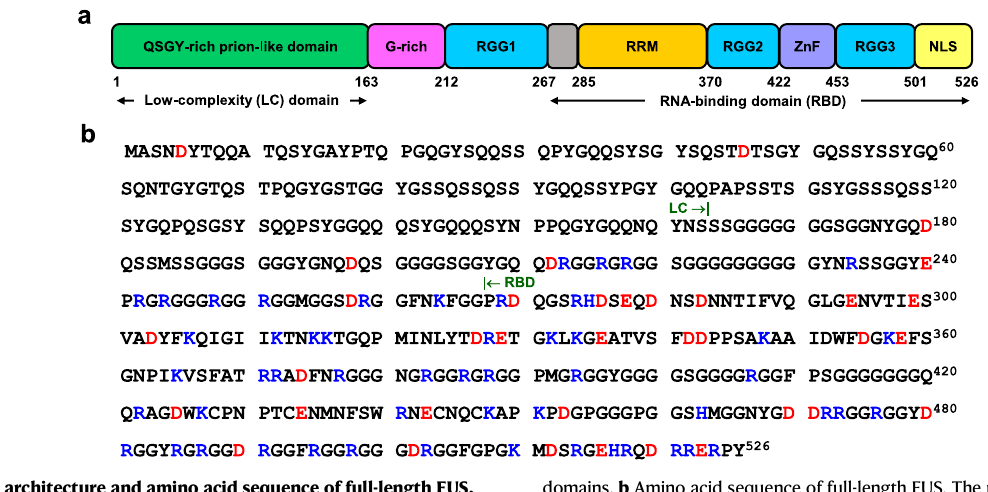
domains. b Amino acid sequence of full-length FUS. The positively and negatively charged residues are highlighted in blue and red,